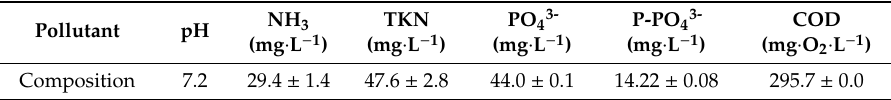
Table 3. Brewery wastewater composition in terms of pH